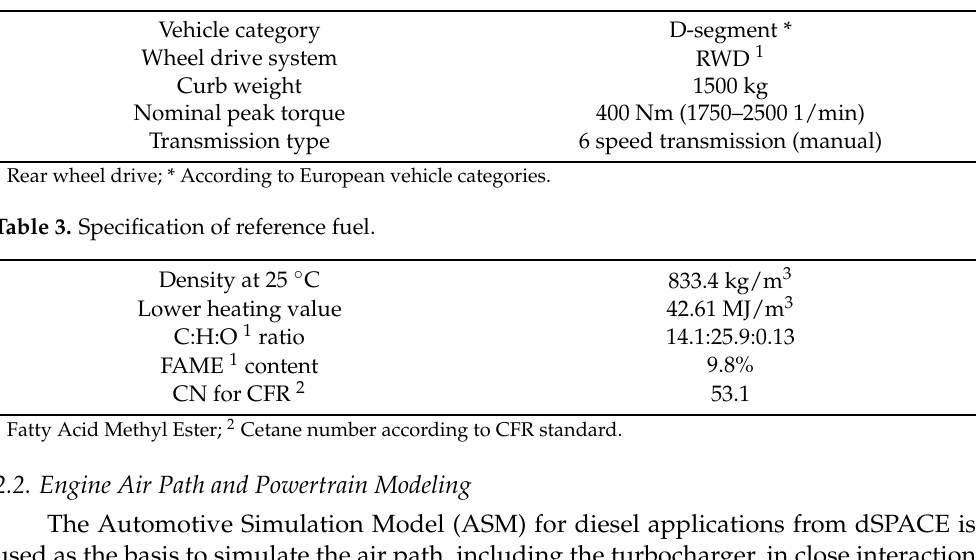
Table 2. Specification of the reference vehicle and transmission.